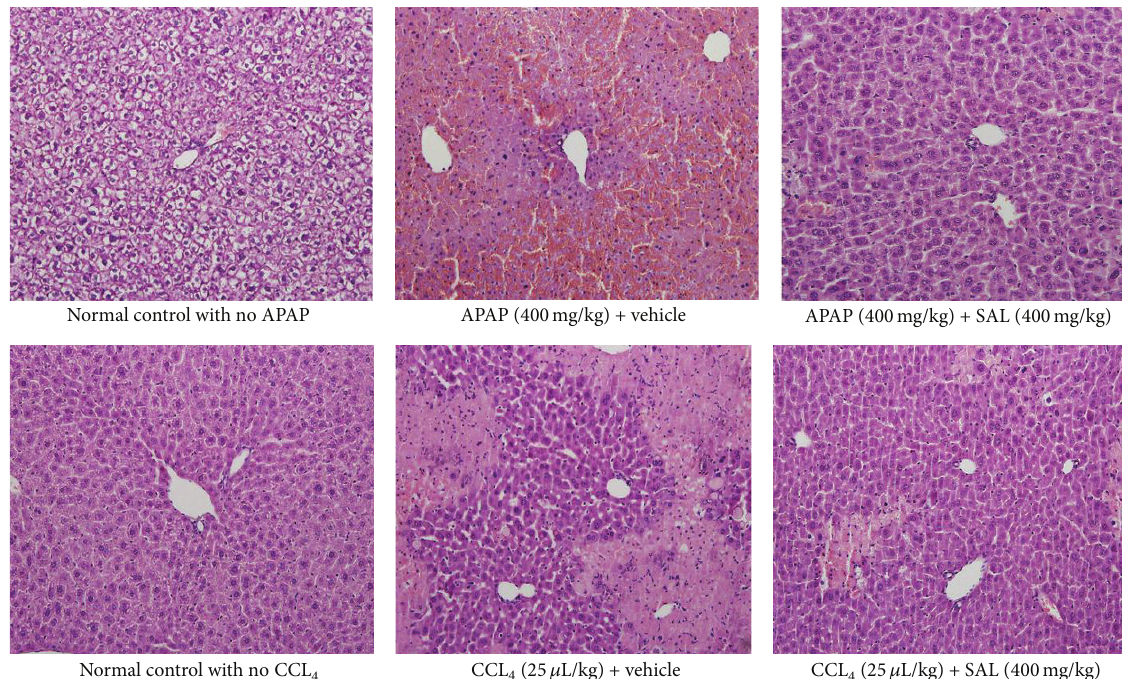
Figure 3: Histopathology of liver tissues from APAP and CCl 4 induced hepatotoxicity models.